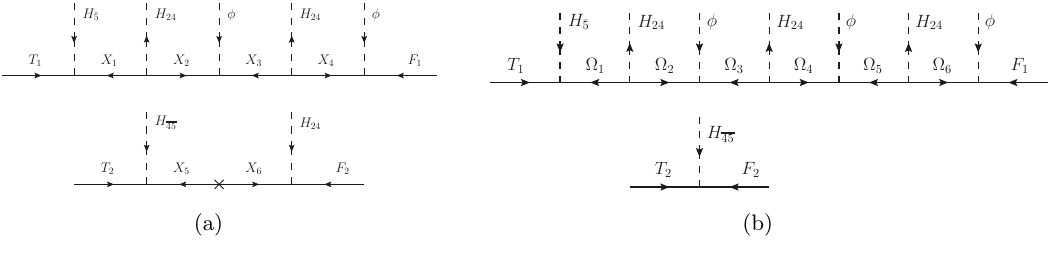
Figure 3 . The supergraphs for the operators in eq. (3.9) (left) and eq. (3.10)